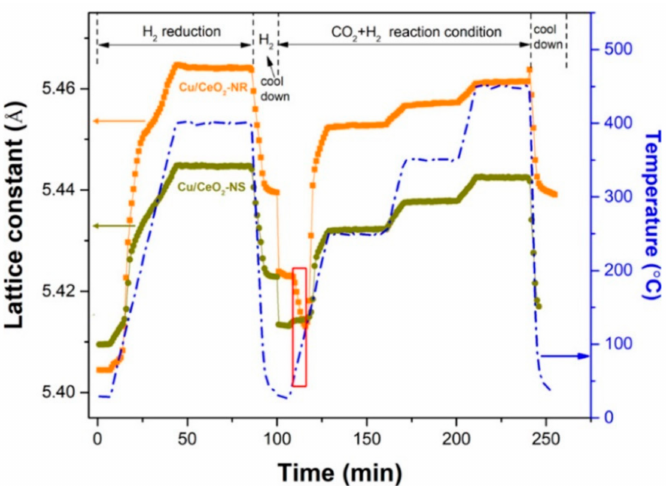
Figure 11. CeO 2 lattice constant for Cu/CeO 2 -NR and Cu/CeO 2 -NS catalysts, reprinted with permission from [81]. Copyright ACS,